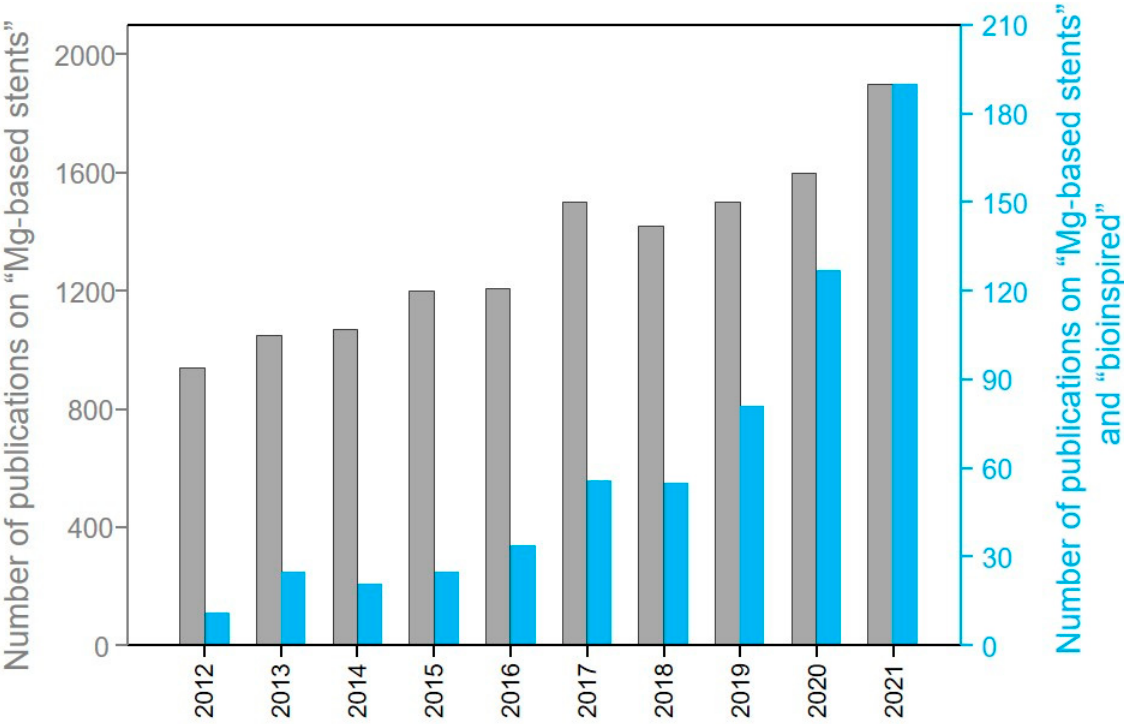
Figure 2. Publications relevant to Mg-based stents and bioinspired strategies research from 2012 to 2021. The information was collected from the Web of Science database with the search date 30 Sep- tember 2022, and the keywords were “Mg-based stents”, “Mg-based stents + bioinspired”.